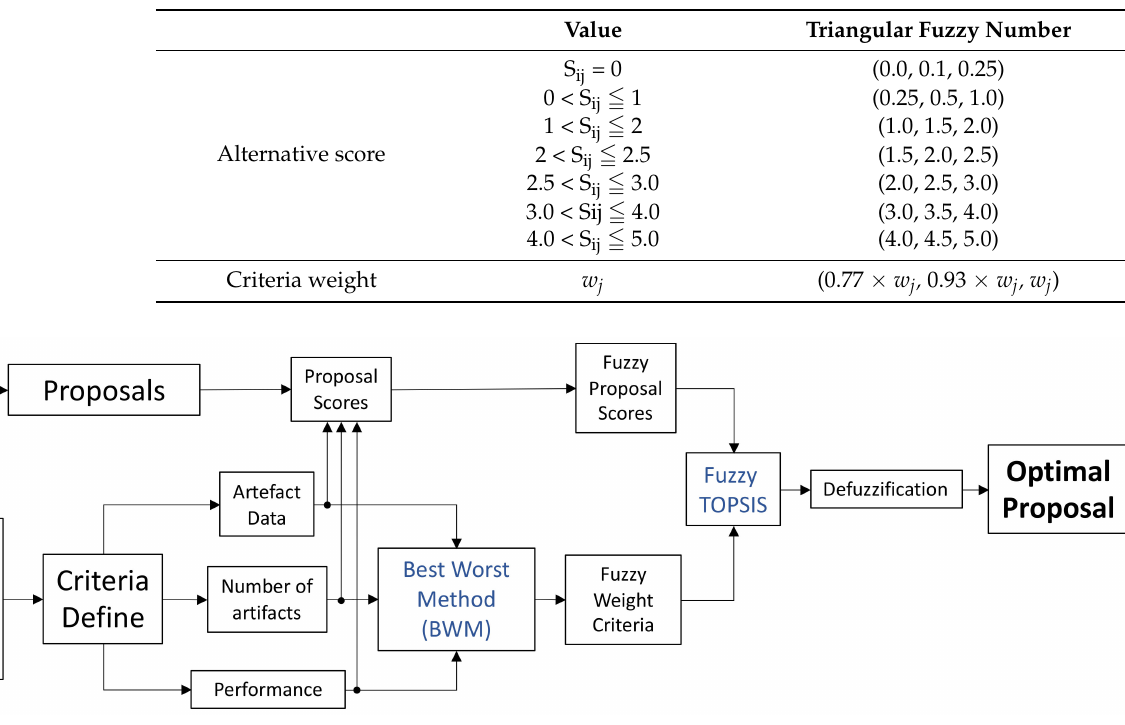
Figure 4. Overall proposal of artefact design